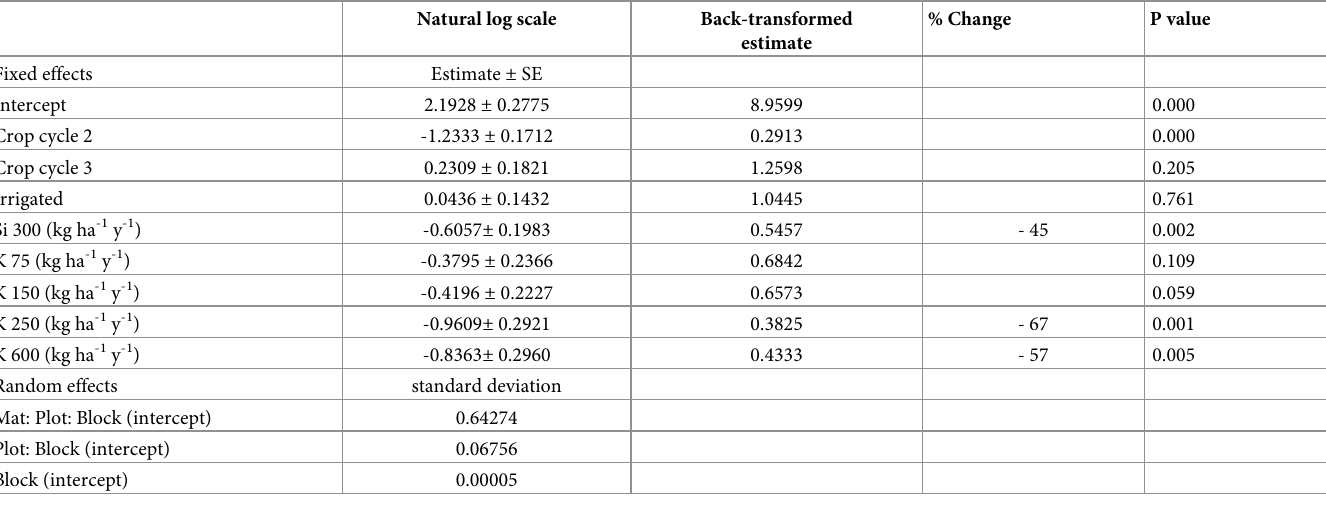
Table 5. Estimates, standard errors (SE), back-transformed estimates and per cent change in weevil damage as a function of pesticide application combined with irrigation or K or Si fertilizer in the potassium response trial analysed using a GLMM with a negative binomial distribution, log link function and Laplace approxi- mation (n = 449). Pesticide and 100 kg N ha y -1 were blankets applied to all treatments shown